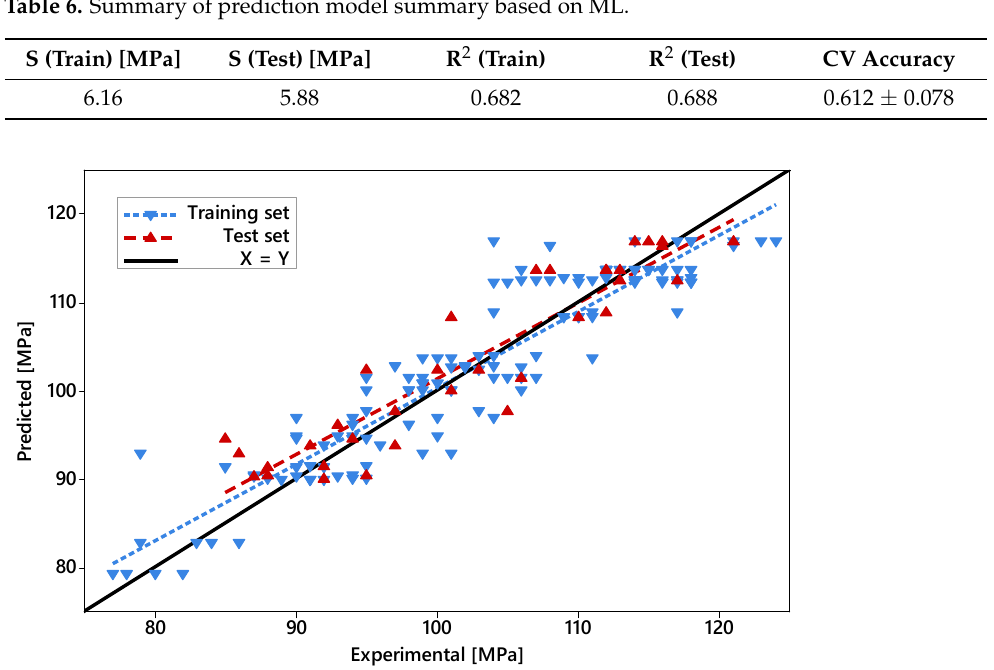
Figure 10. Scatterplot of predicted UTS (according to the ML-based model) against the experimental UTS. Dashed lines were fitted based on each set.